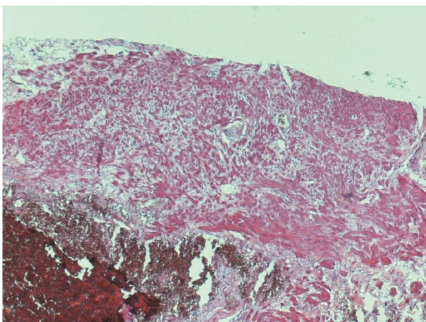
Figure 2: Photomicrograph shows portion of rectal muscularis propria identified at the deep aspect of the specimen (hematoxylin and eosin stain, original magnification ×